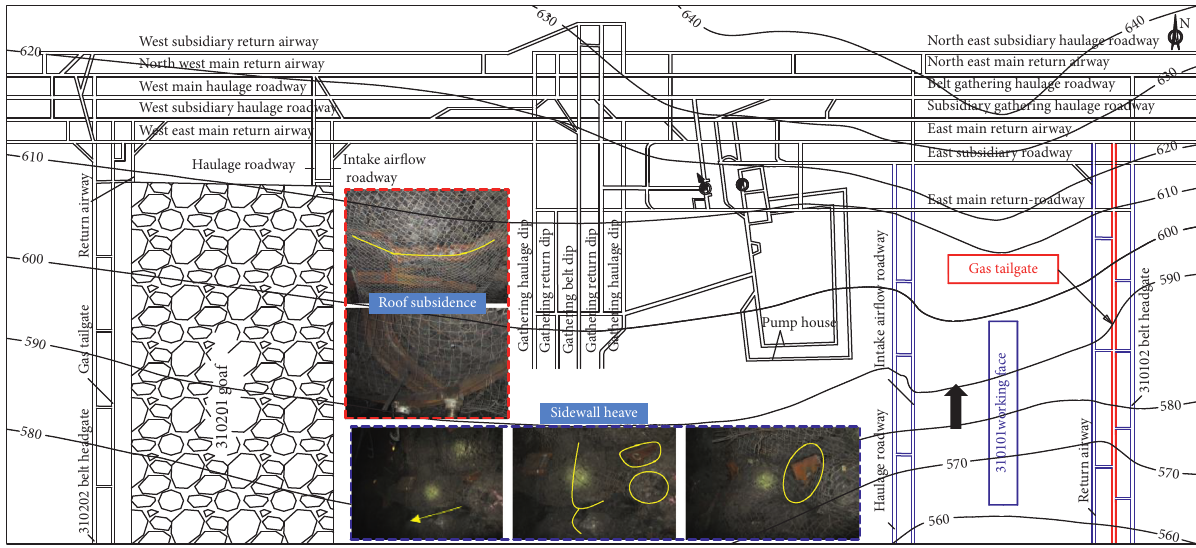
Figure 3: Rock pressure failure of soft coal